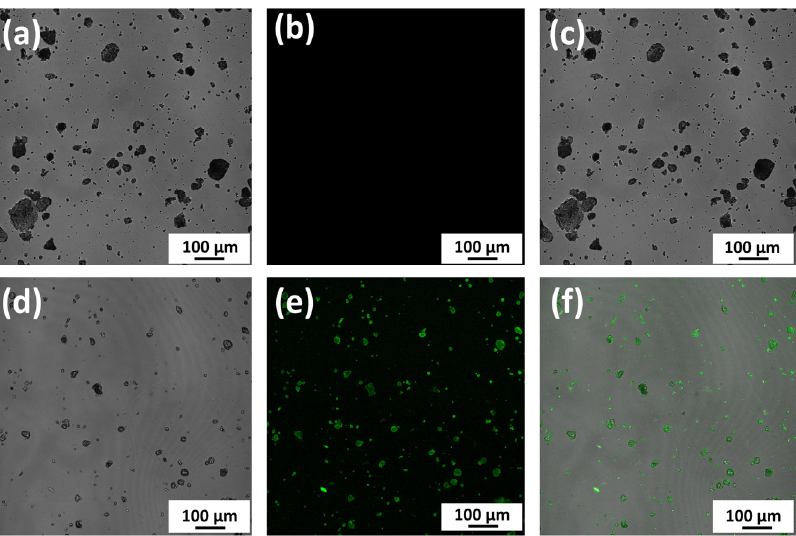
Figure 11. ( a ) The bright field, ( b ) fluorescence, and ( c ) overlay images of nHAp particles without FITC-labeled collagen (nHAp*FITC-Collagen ( − )); ( d ) bright field, ( e ) fluorescence, and ( f ) overlay images of nHAp particles mixed with FITC-labeled collagen (nHAp*FITC-Collagen (+)).